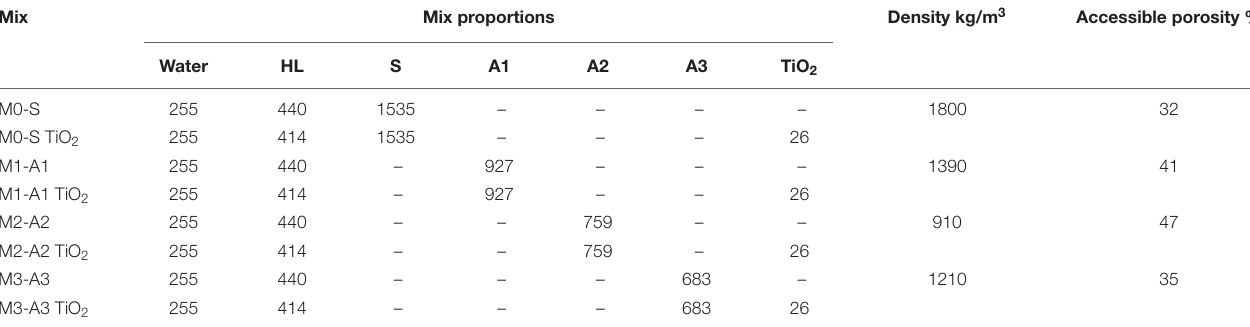
TABLE 2 | Mix proportions (g/L), density (kg/m 3 ), and accessible total porosity (%) of mortars.